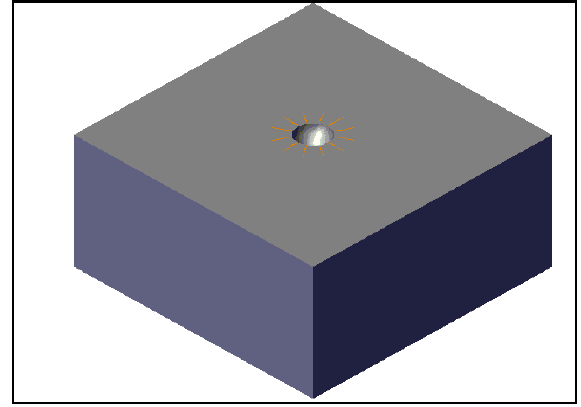
Figure 2. Void model in continuum mechanics domain.